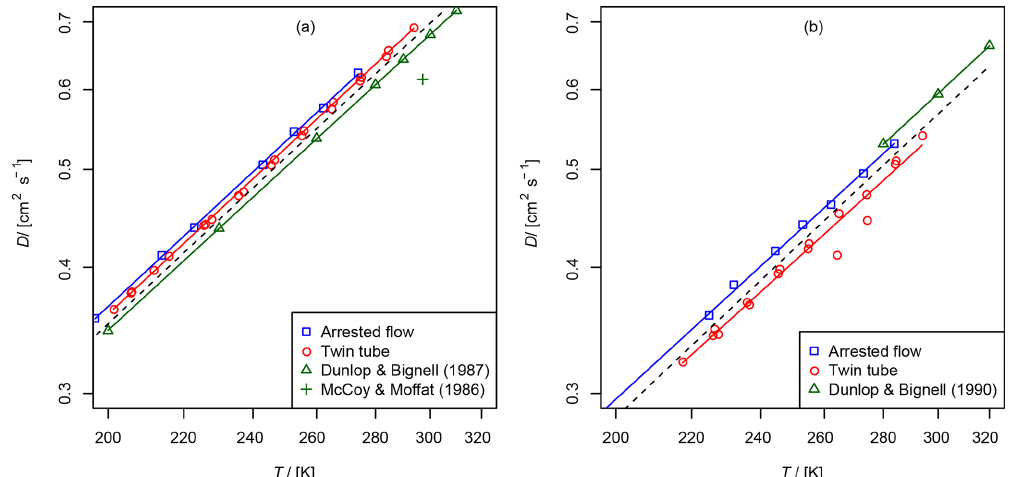
Figure 6. Comparison of diffusion coefficients obtained by the AF and TT method: (a) diffusion coefficient of methane in helium compared to data from Dunlop and Bignell (1987) (fit D 0 = 0 . 582cm 2 s − 1 , b = 1 . 66) and D = 0 . 614cm 2 s − 1 at 297K from McCoy and Moffat (1986). (b) Diffusion coefficient of ethene in helium compared to data from Dunlop and Bignell (1990) (fit D 0 = 0 . 508cm 2 s − 1 , b = 1 . 68). The dashed line is calculated by the Lennard–Jones model.